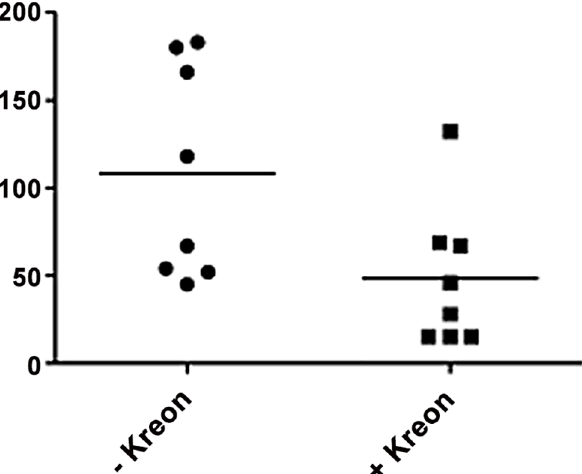
Fig 2. Comparison of fecal elastase levels in patients with pancreatic insufficiency before and after a minimum of 4 months of pancreatic enzyme replacement therapy with pancreatin (at least 200.000 units per day. In seven of eight patients the polyclonal fecal elastase ELISA determined a reduction fecal elastase levels indicating reduced exocrine secretion under replacement therapy and excluding cross reactivity with elastases contained in